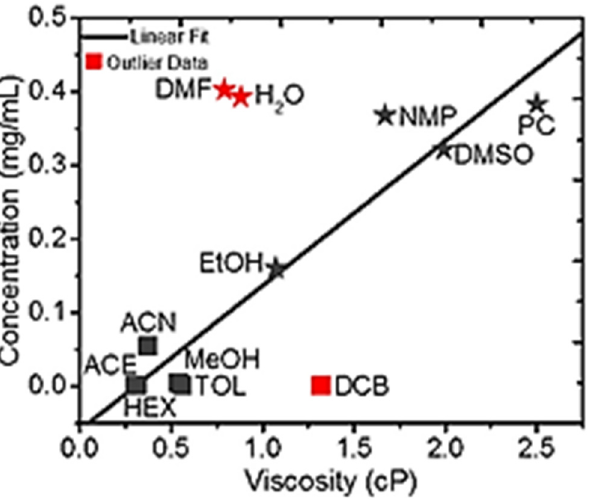
Figure 7. Linear relationship between MXene concentration and solvent viscosity for all solvents excepting DCB, DMF, and water [30]. Copyright 2017 American Chemical Society.